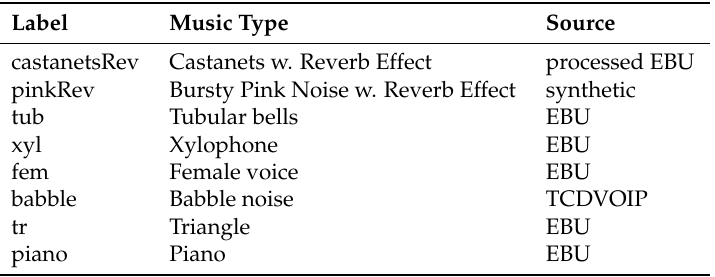
Table 4. Multiple point audio samples used during listening tests.